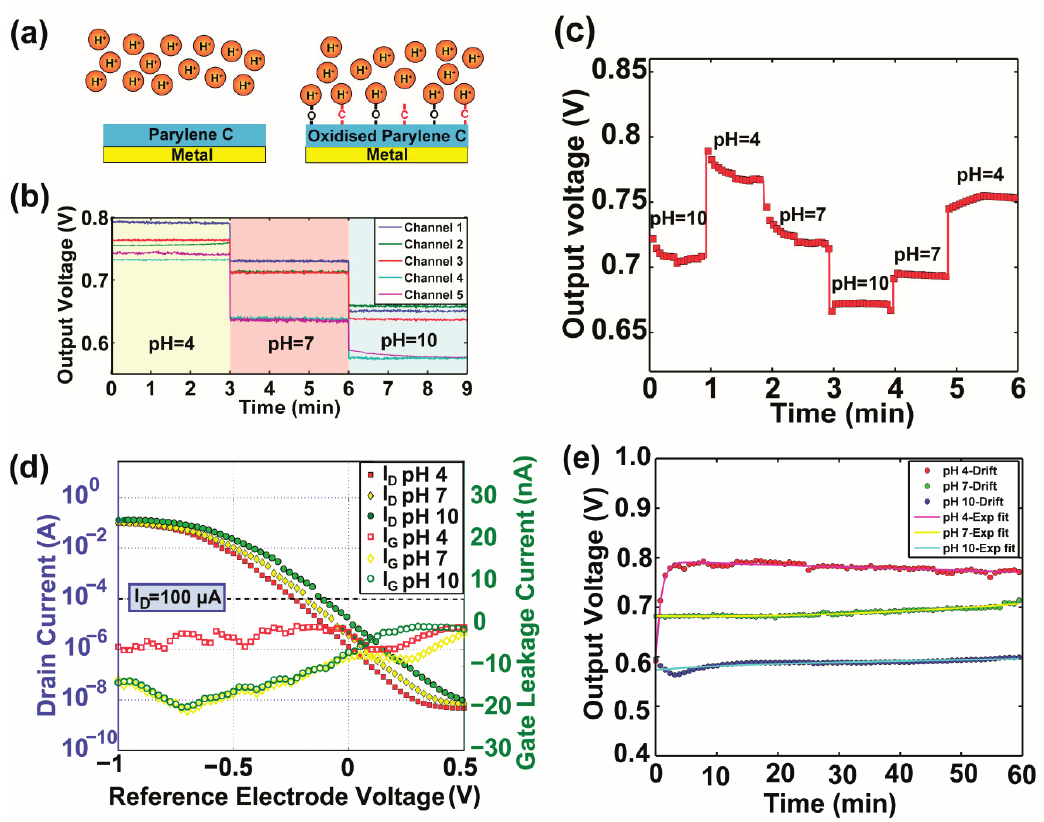
–V curves of D GS